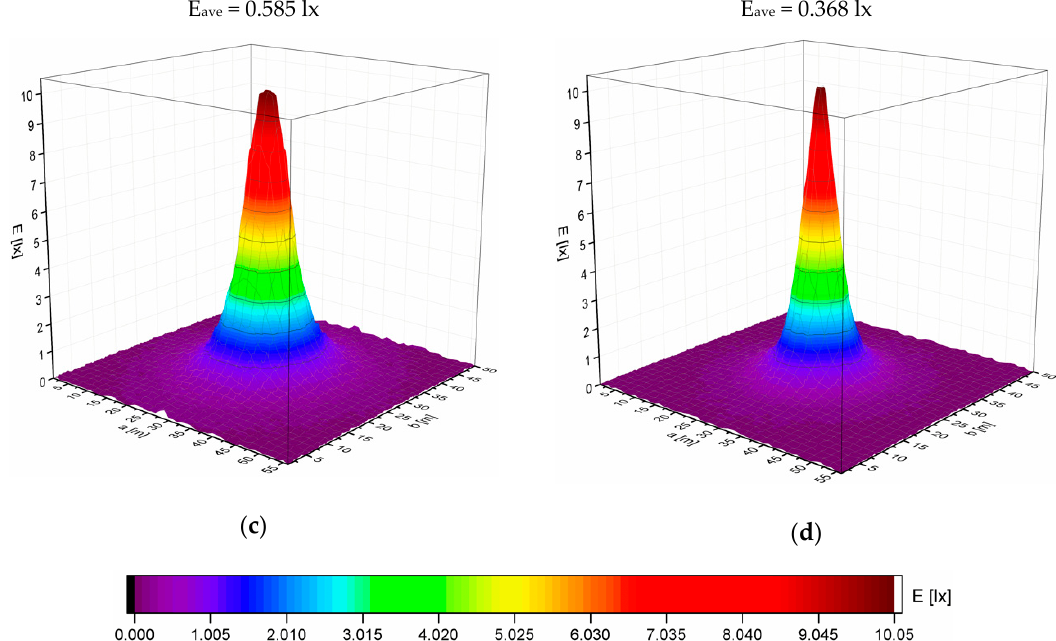
Figure 9. Visualization of the illuminance distribution when using: ( a , c ) oval ball, ( b , d ) oval ball half-covered with black paint, recorded values relate to measurements taken: ( a , b ) from the air using a UAV, ( c , d ) on the ground.